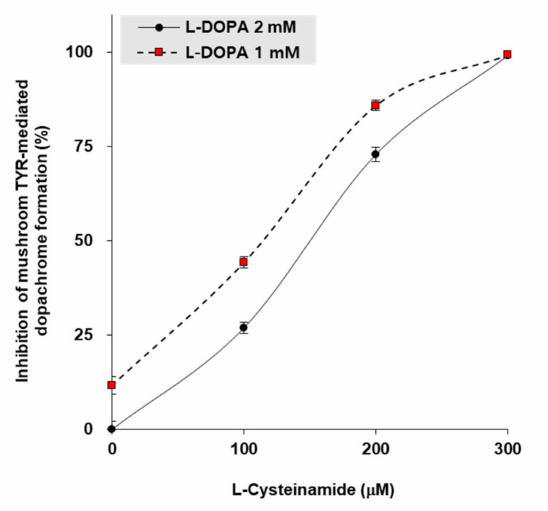
Figure 7. Inhibition of mushroom TYR-mediated dopachrome formation by L-cysteinamide. Mushroom TYR-mediated dopachrome formation was measured at varying concentrations of L- dihydroxyphenylalanin (DOPA) and L-cysteinamide. Data are presented as mean ± SD ( n =